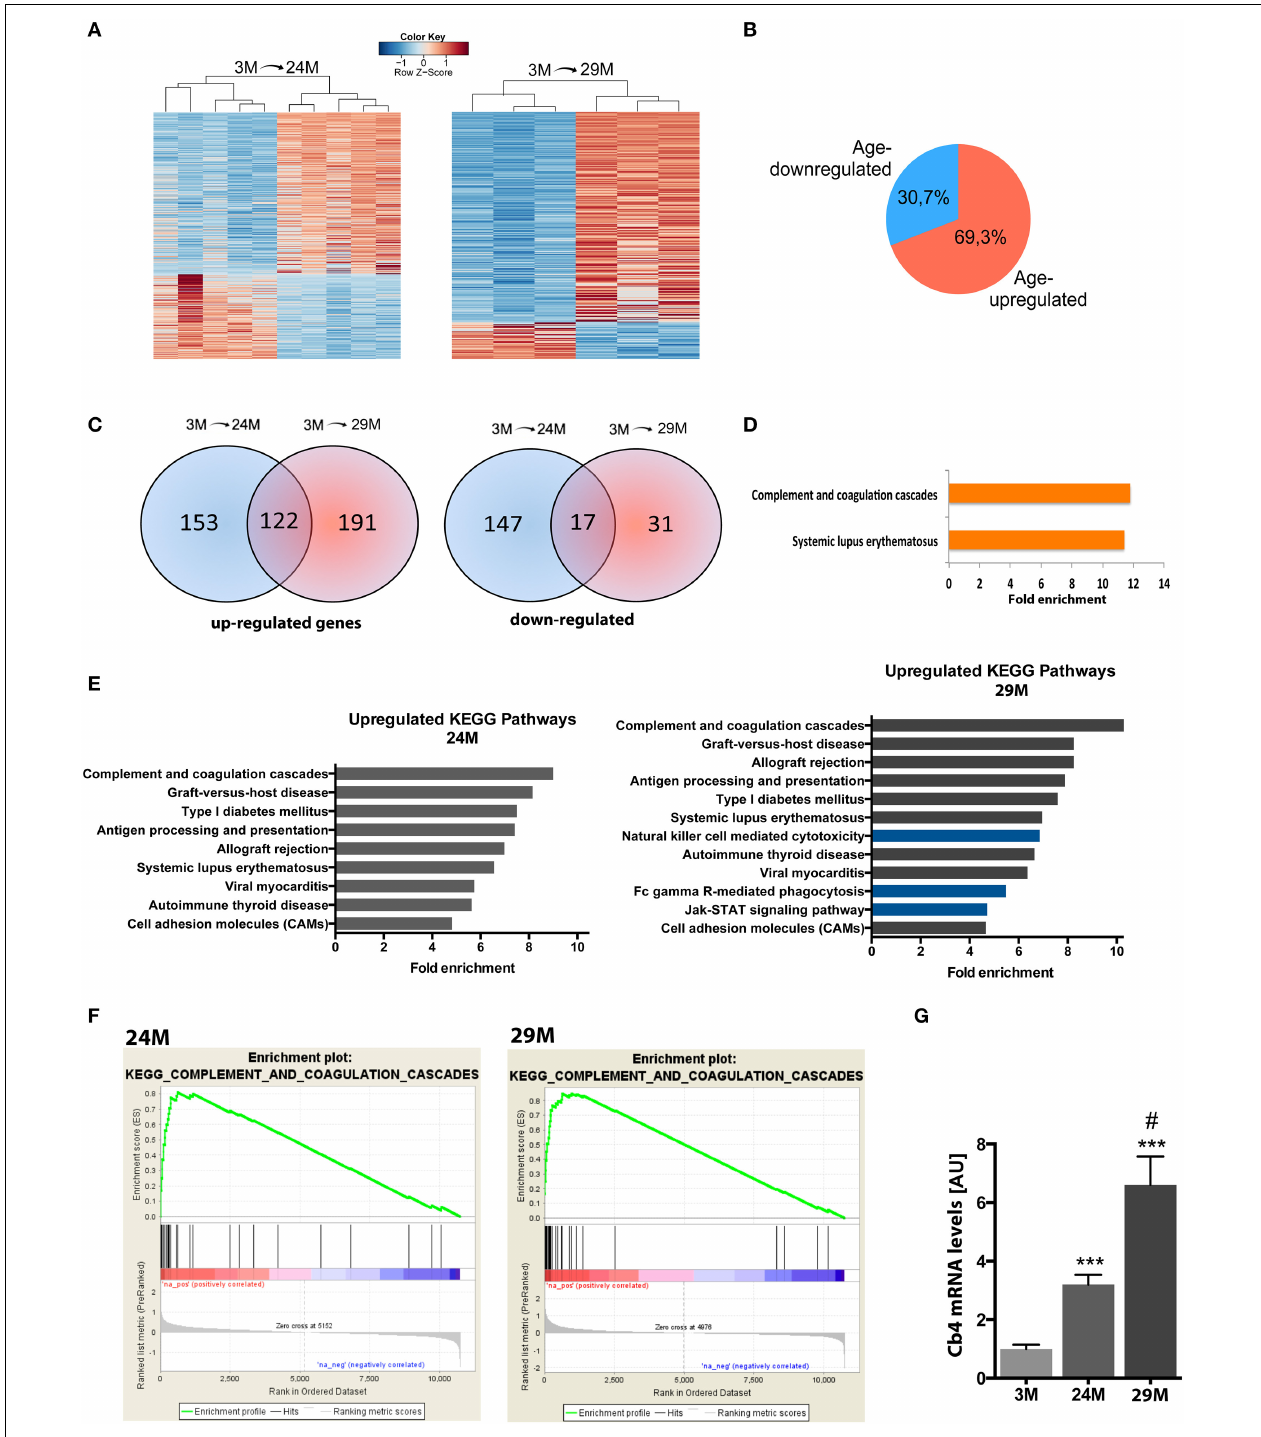
FIGURE 2 | Aging is associated with changes in gene expression and upregulation of immune system functions in the hippocampus. (A) Heatmaps of differentially expressed genes in 3-month (3M) and 24-month-old mice (24M, left panel) and 3 and 29-month (29M) old mice (right panel). High expression is marked by the red color spectrum, low expression by blue colors. (B) Pie chart showing the percentage of genes up-and down-regulated in 3 vs. 24/29 month-old mice. (C) Venn diagrams comparing significantly regulated genes found in the different experiments (3M vs. 24M